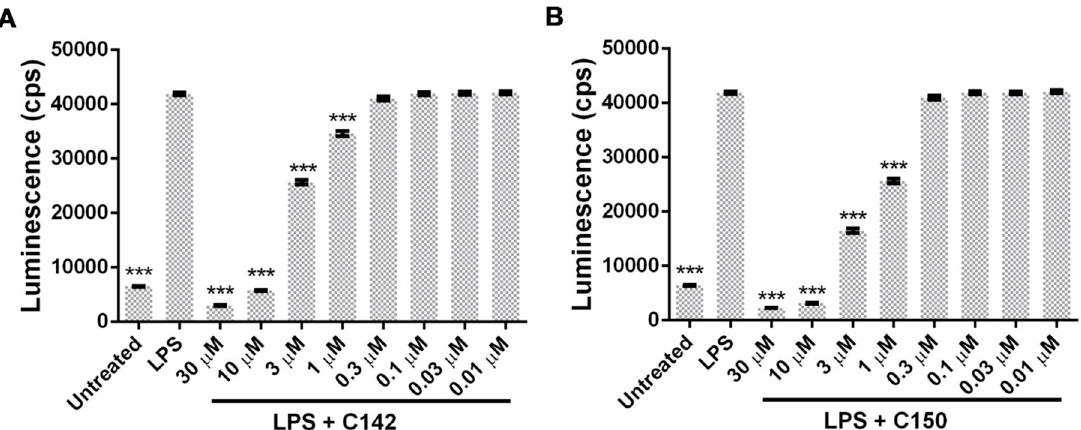
Figure 7. Mannich curcuminoids ( A ) C142 and ( B ) C150 inhibit lipopolysaccharide (LPS)-induced NF- κ B activation in a concentration-dependent manner, as described in Section 4.7 of Materials and Methods. Luminescence (counts per seconds (cps)) is proportional to NF- κ B-driven transcriptional activity. Results are shown as mean ± S.E.M.; *** p < 0.001 pair-wise comparison with LPS-treated group.